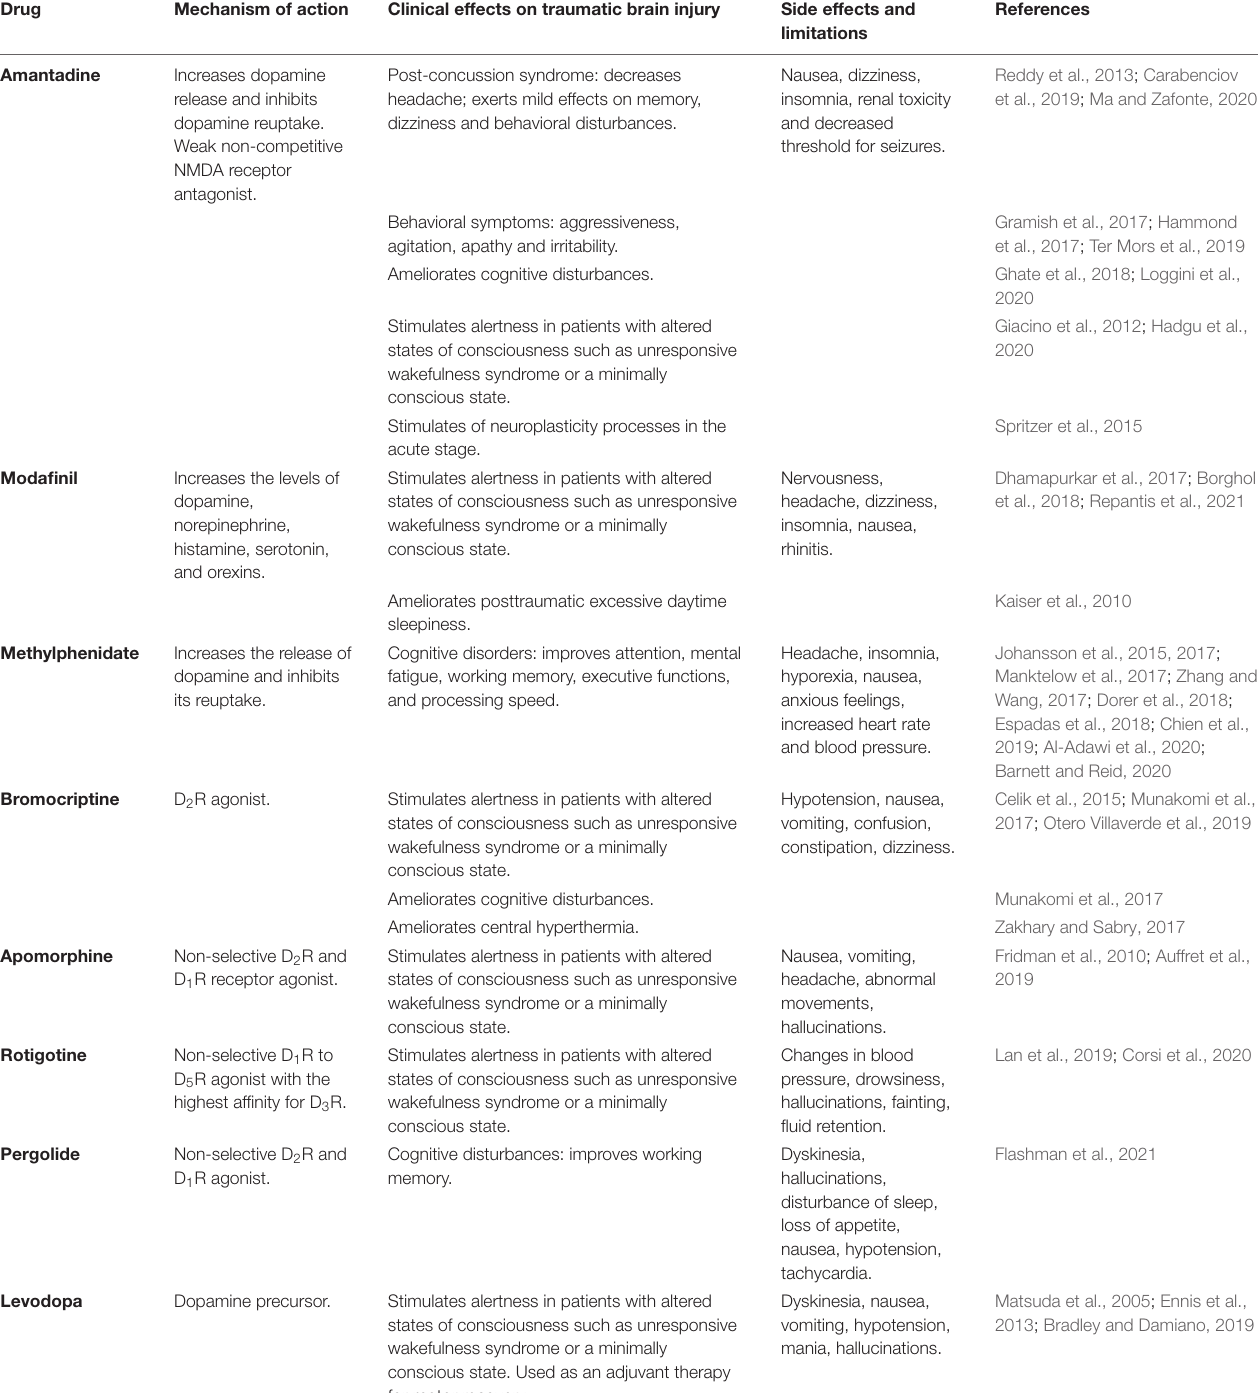
TABLE 1 | Main clinical effects of dopaminergic drugs on traumatic brain